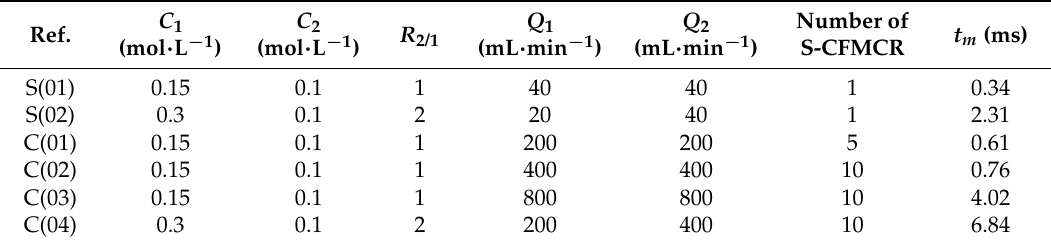
Table 2. Operating parameters for MnO 2 precipitation in S-CFMCR and C-CFMCR.